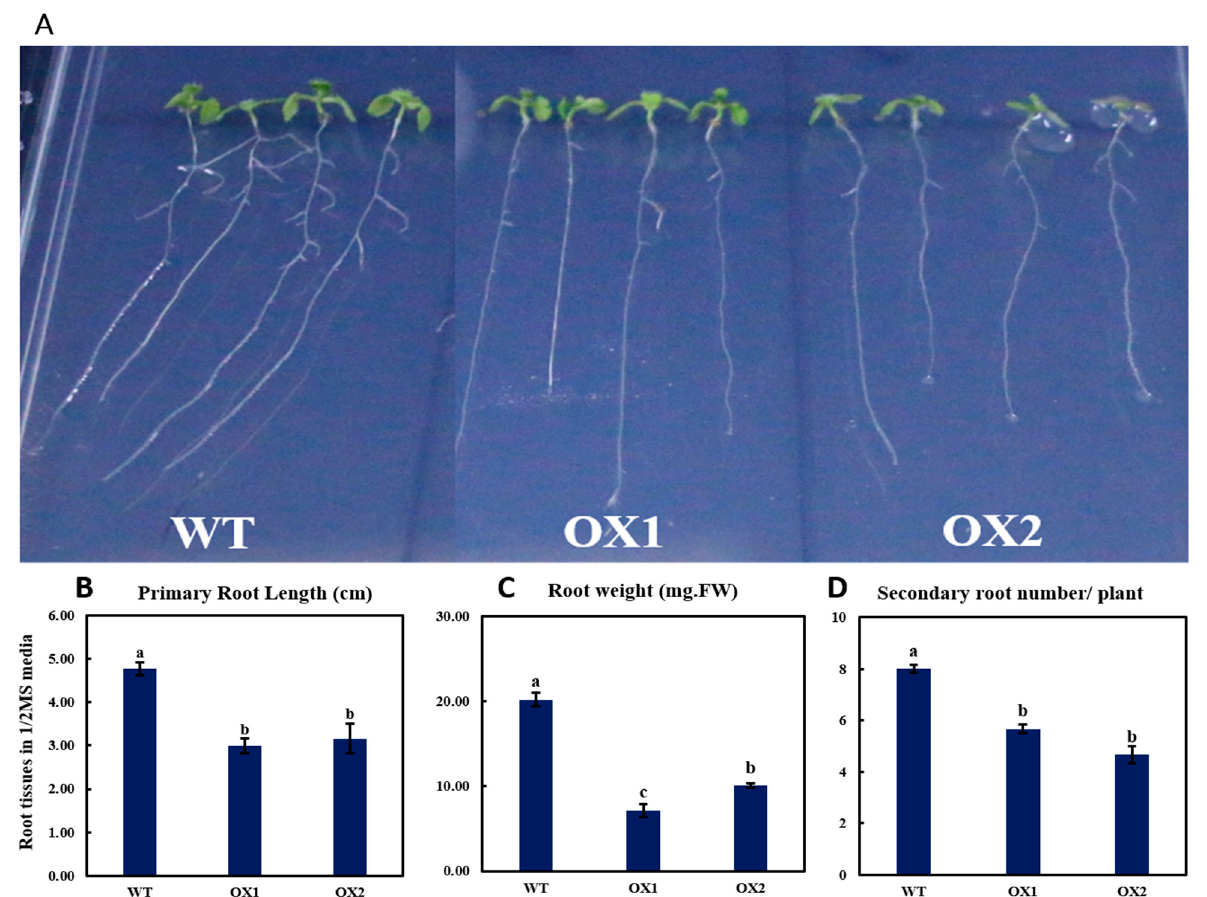
Figure 3. Light-microscopy images of different TEA031065 -over-expression allele phenotypes for roots and their statistical growth rates in transgenic plants ( A. thaliana ). ( A ) Phenotypes of 21-day-old OX-1 and OX-2 versus wild type; ( B ) primary root length; ( C ) root weight; and ( D ) secondary root number/plant of control (CK)/wild-type and transgenic (lines 1 and 2 gene overexpression) plants for 14 days. The LSD analysis shown the significant differences among the different treatment by the lowercase letter a > b > c. The values imply means of three biological replicates ± SD. p < 0.05.